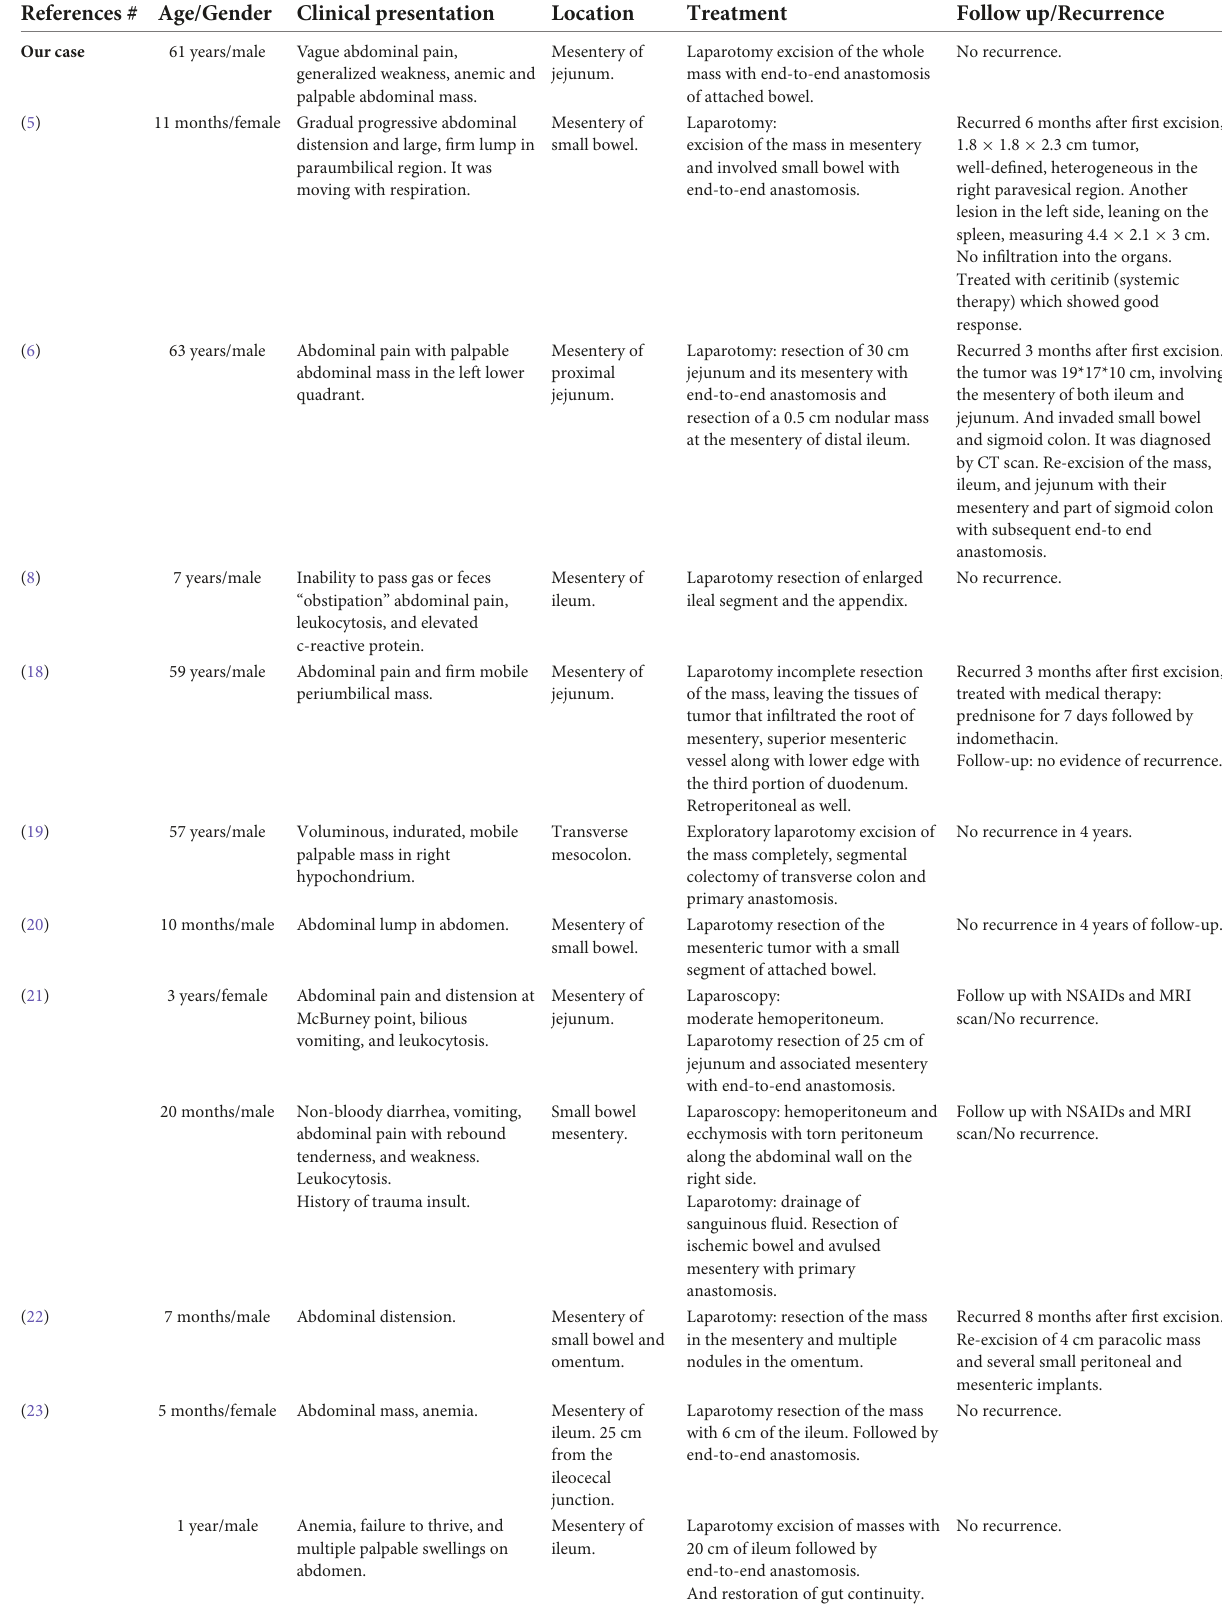
TABLE 1 Clinical features of the reported cases of inflammatory myofibroblastic tumor of the